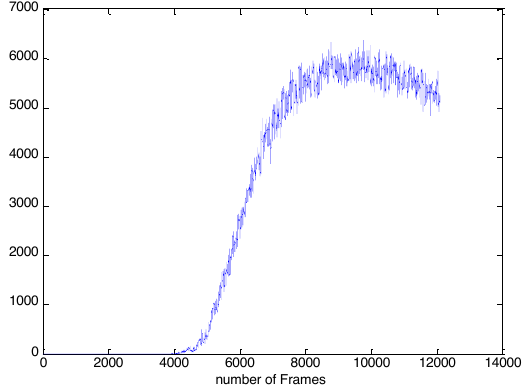
Figure 3. The evolution of total number of microbes in the whole plate, according to Equation